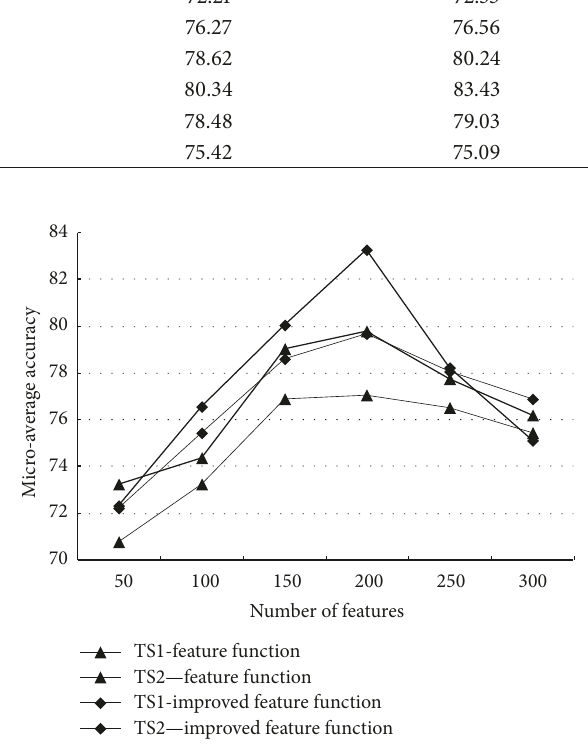
Figure 2: Micro-average accuracy comparison among different training sets.